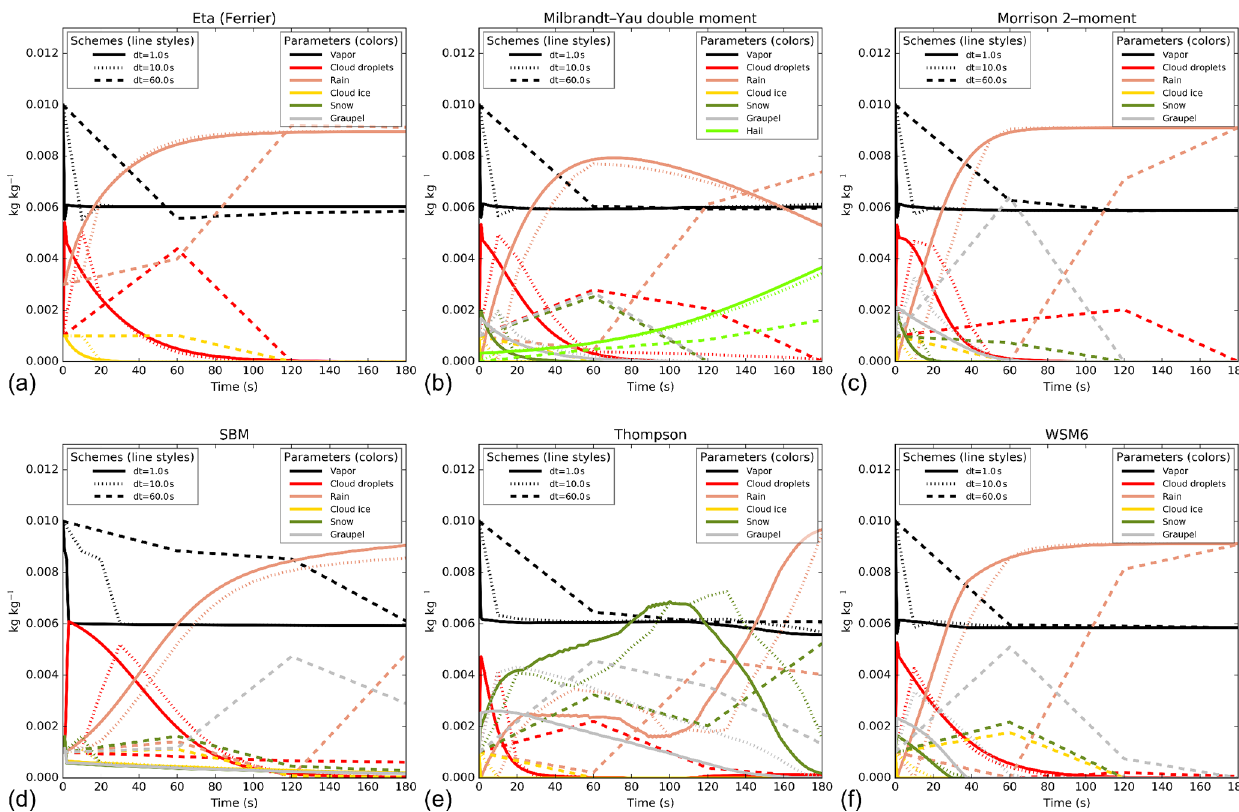
Figure 3. Same as Fig. 1a but using some schemes of the WRF model identified in the panel titles (see text for complete references).